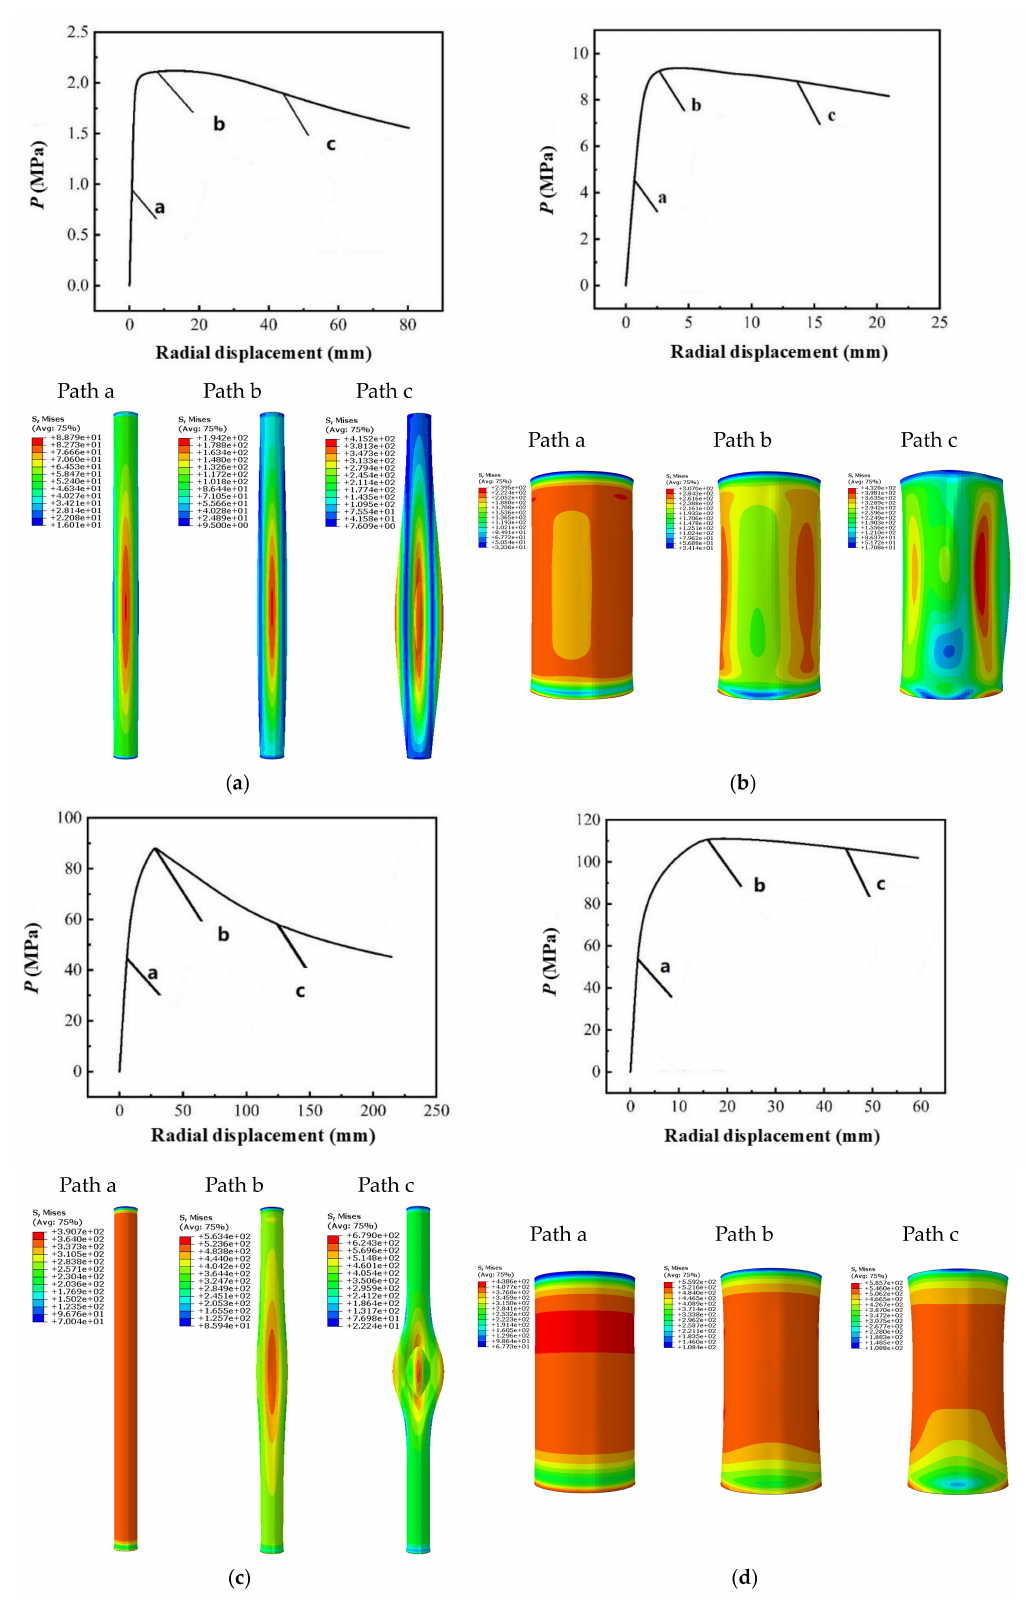
Figure 15. Buckling deformation diagrams of model 1~4 ( a ) Model 1; ( b ) Model 2; ( c ) Model 3; ( d ) Model